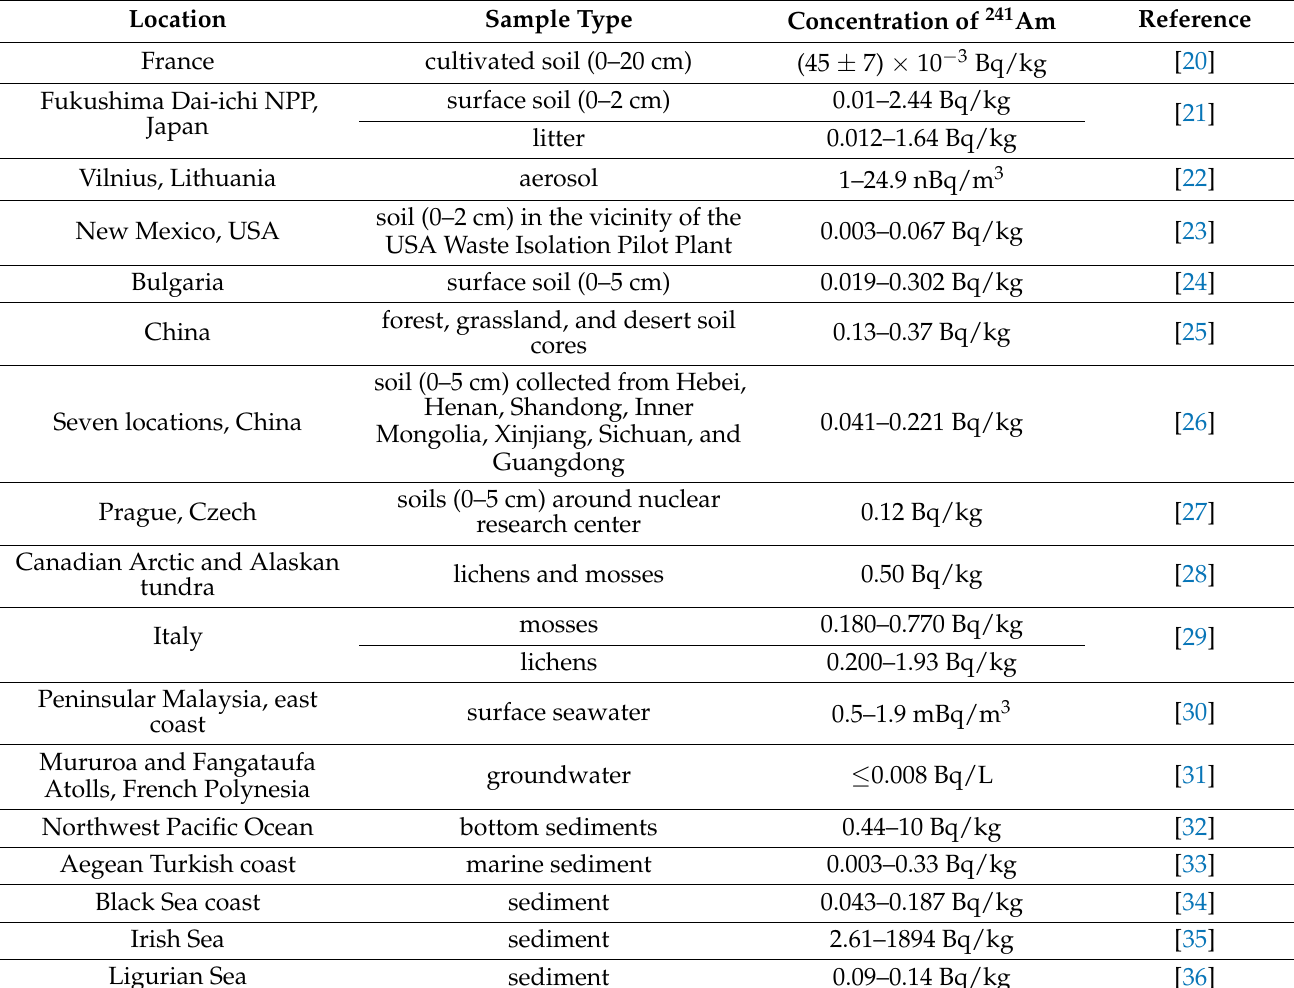
Table 2. Distributions of 241 Am in some specific